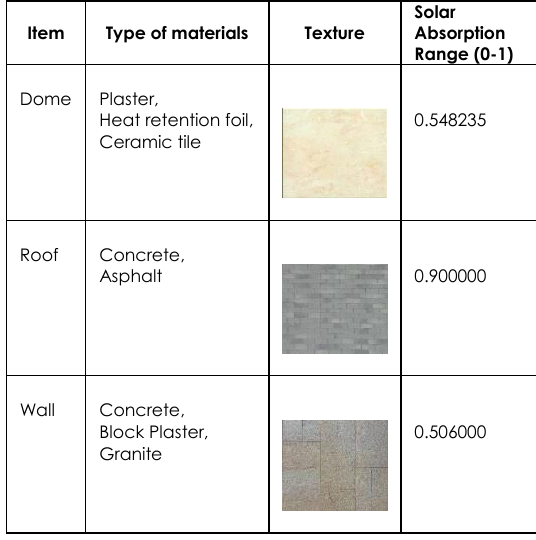
Table 1. Materials properties of Palace of Justice building